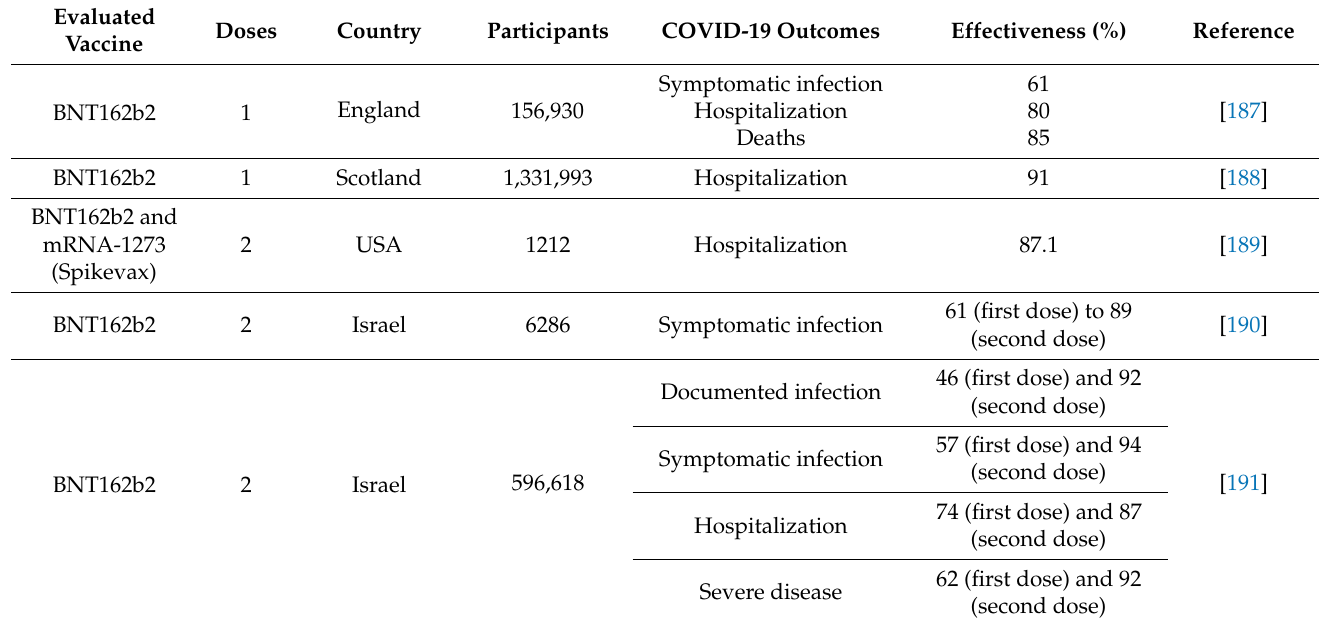
Table 5. Effectiveness of approved RNA-based vaccines against COVID-19 from other studies (real-world conditions). Evaluated